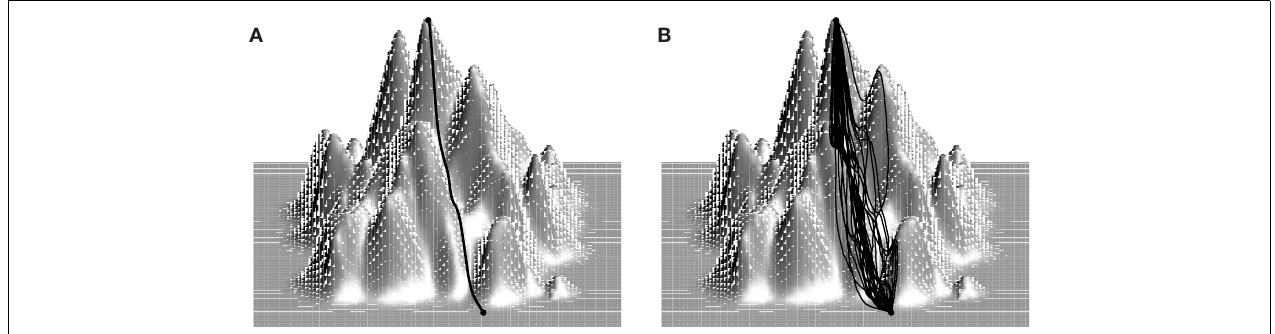
mutation rate is high. (B) If each clone is allotted its own trajectory, the evolution of the population can be represented by a bundle of trajectories which split and terminate on the way to the summit. At any given time the population can be represented by a probability density function in sequence